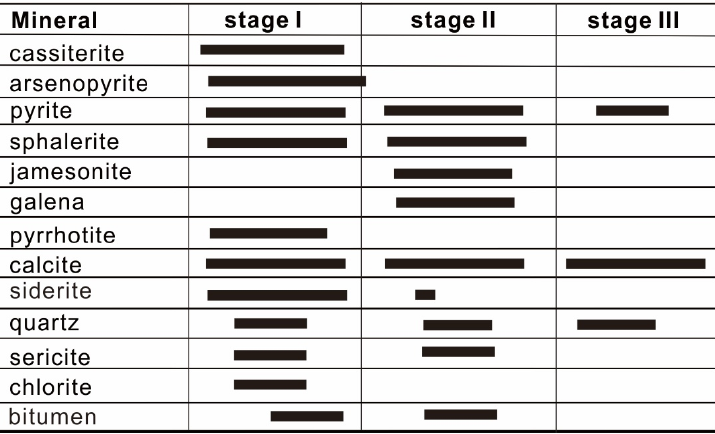
Figure 3. Paragenetic sequence of the different mineralization stages at Beixiang.